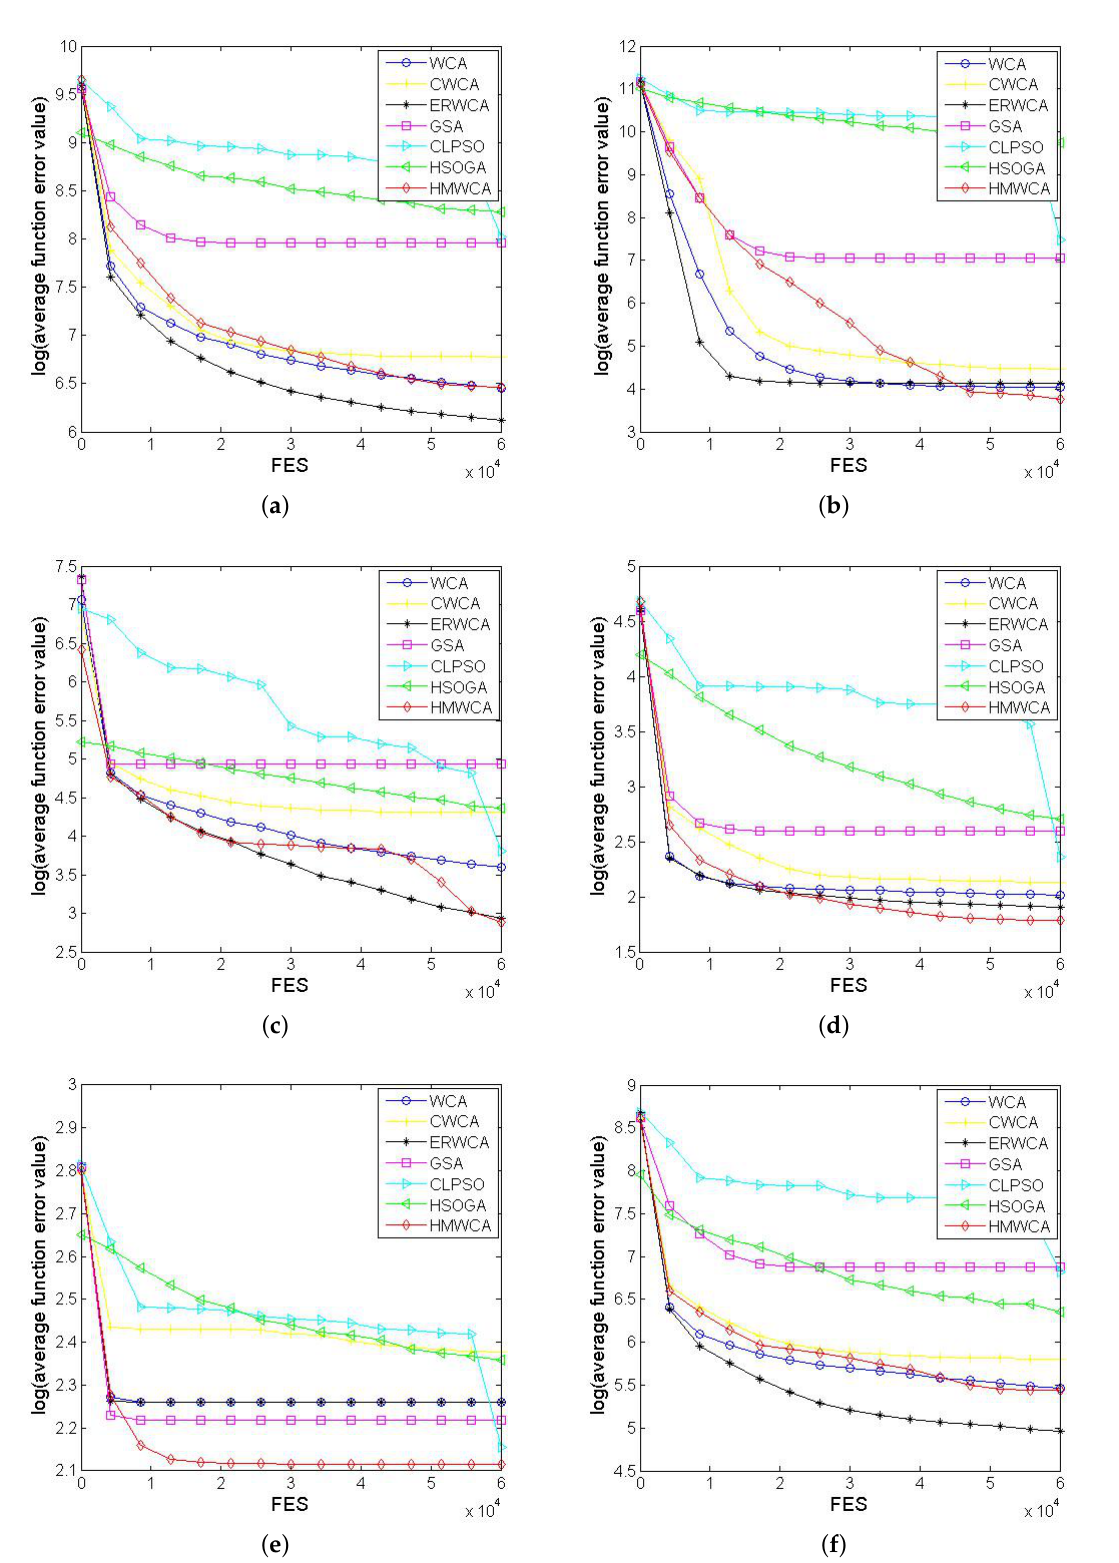
Figure 1. The evolution curves of the seven studied algorithms for functions ( a ) f 1 , ( b ) f 2 , ( c ) f 3 , ( d ) f 4 , ( e ) f 9 and ( f ) f 17 with D =